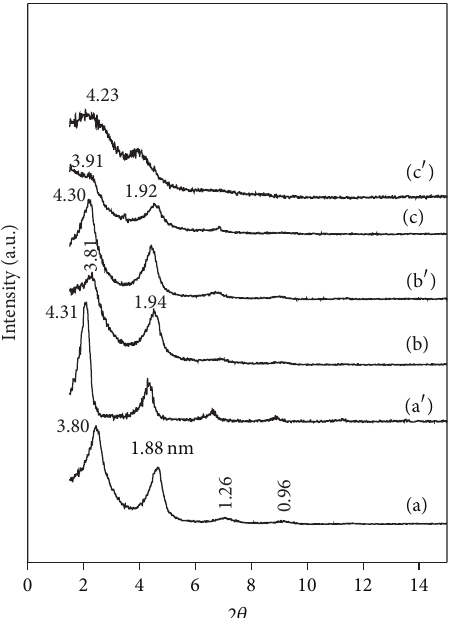
Figure 1: Powder XRD patterns of (a) C16TMA-Mt, (b) C16TMA- AMt0.2, (c) C16TMA-AMt0.5, (a 󸀠 ) PVP/C16TMA-Mt, (b 󸀠 ) PVP/ C16TMA-AMt0.2, and (c 󸀠 ) PVP/C16TMA-AMt0.5.